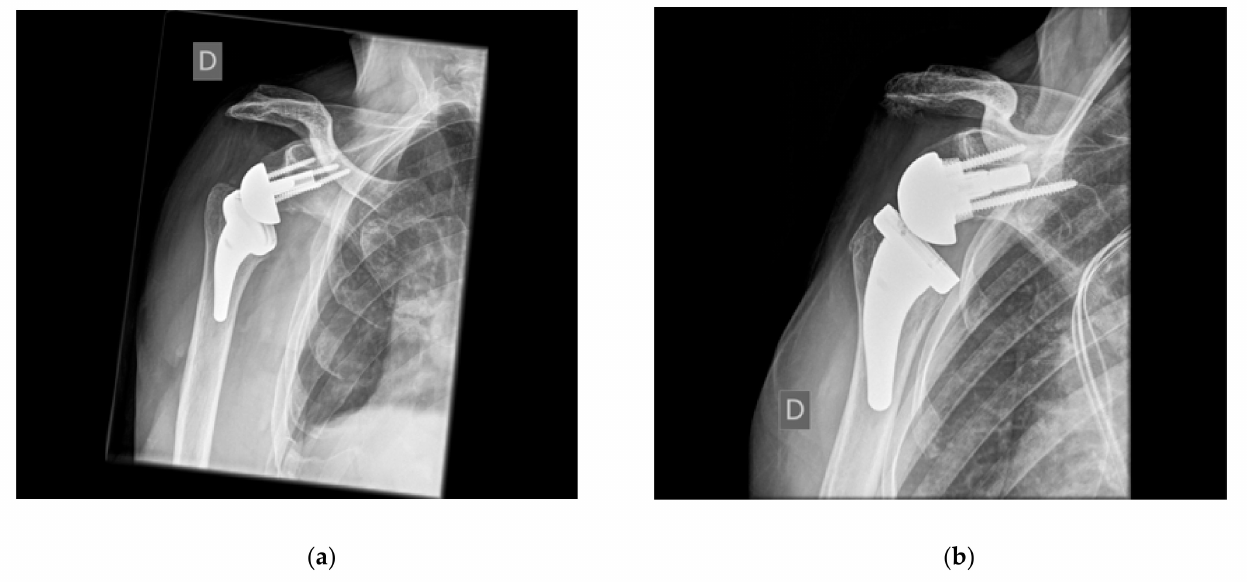
Figure 4. Lateralized RSA after ORIF (Open Reduction Internal Fixation)/osteonecrosis in a young patient after a fracture dislocation and plating. The revision required humeral canal opening with a burr. Outstanding ROM. Radiograph: Combined humeral and glenoid lateralization (Bipolar lateralization; 145 ◦ stem, forced varus implantation as a result of sclerosis/insufficient bone stock). Yellow line: Augmented distance from the insert to the lateral scapular margin.